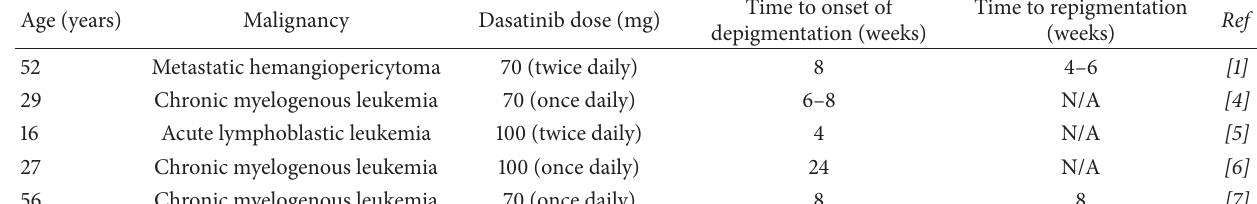
Table 1: Summary of cases reporting dasatinib-induced hypopigmentation.